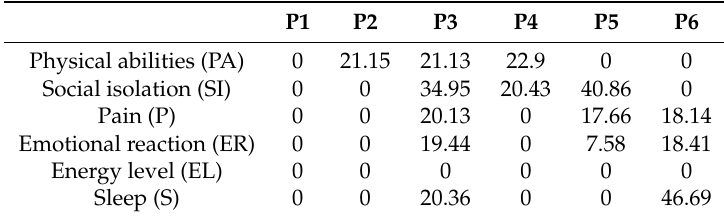
Table 2. Participant NHP